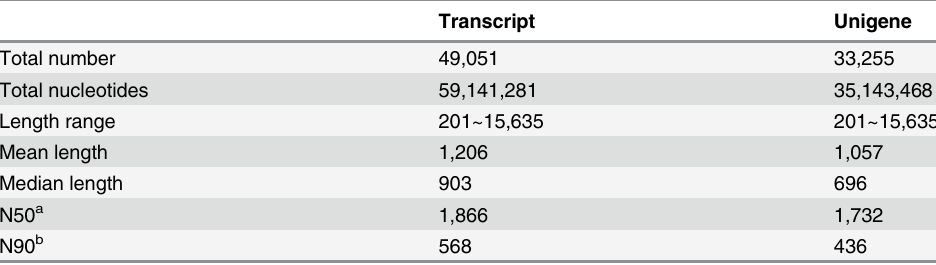
Table 2. General features of the primary root transcriptome of A . sparsifolia